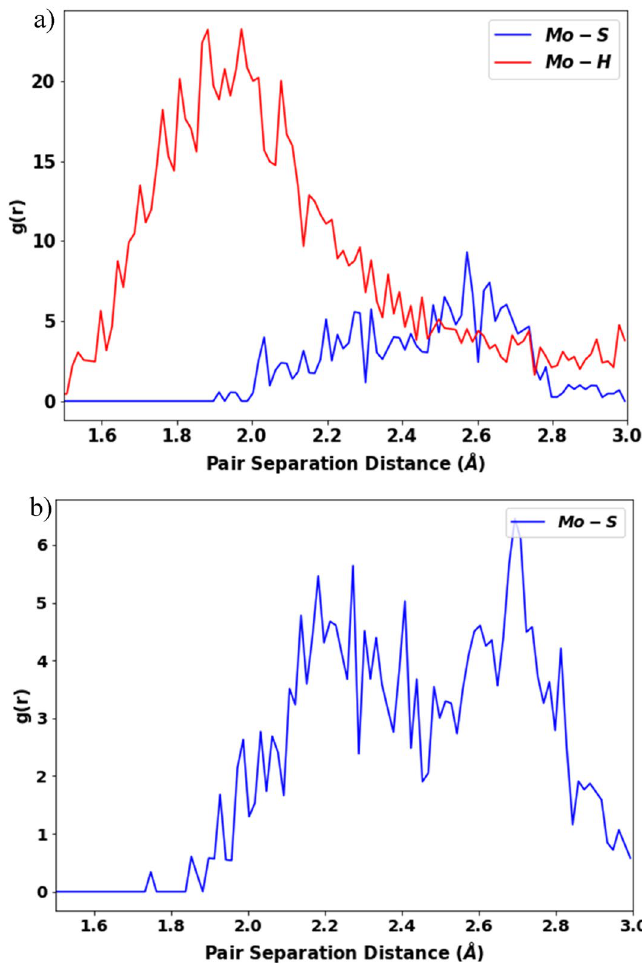
Figure 11. Radial distribution function of ( a ) Mo-S and Mo-H bonds of the H 2 S precursor system and ( b ) Mo-S bonds of the S 2 precursor system at 375